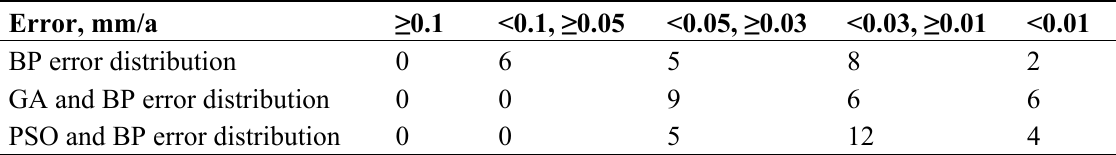
Table 10. The absolute errors of the corrosion rate predicted by BP, GA and BP, PSO and BP.